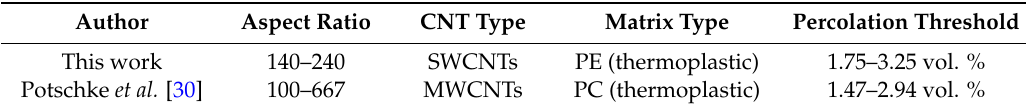
Table 3. Comparison of percolation threshold results with values from other authors.